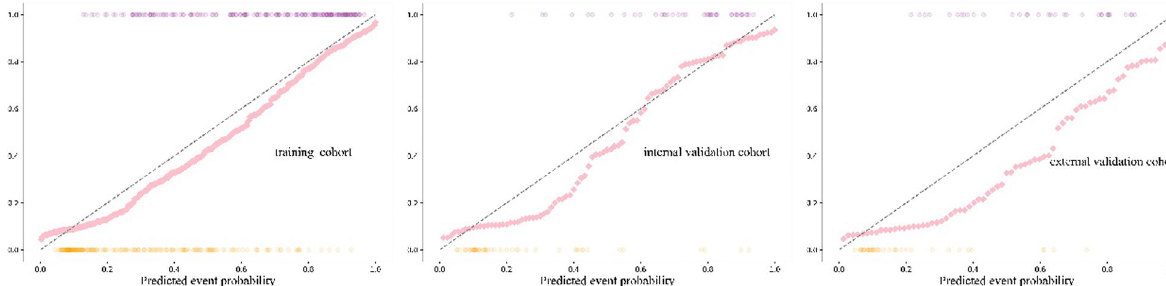
Fig. 6 Calibration curves for the clinical–radiomics model in the training and validation cohorts